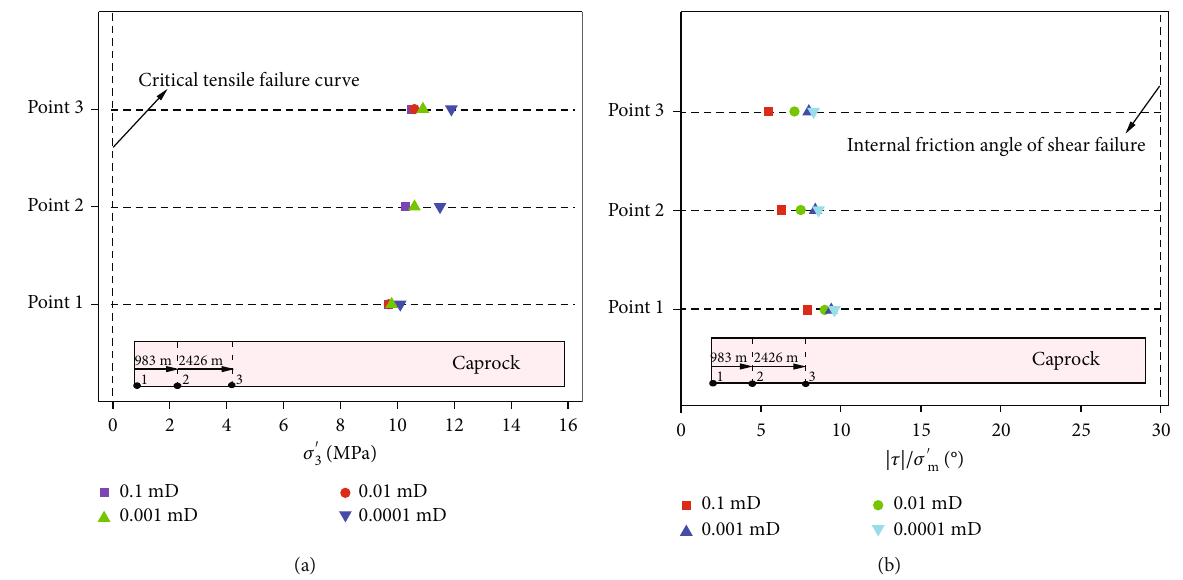
Figure 23: In fl uence of permeability coe ffi cient of caprock on mechanical integrity of caprock. (a) The minimum principal stress. (b) Critical internal friction